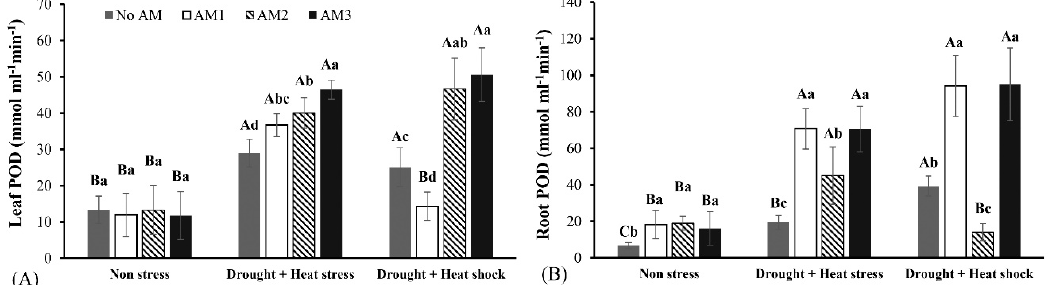
Figure 2. The activity of peroxidase (POD) in leaves ( A ) and roots ( B ) of non-inoculated plants (No AM) and plants inoculated by R. irregularis (AM1), F. mosseae (AM2), or F. coronatum (AM3) subjected to non-stress (NoS), drought + heat stress (D + H), and drought + heat shock (D + HS). Each bar represents the mean and standard deviation (n = 4). Di ff erent minuscules indicate significant di ff erences among treatments under the same conditions (no stress, drought + heat stress, or drought + heat shock) by Duncan’s post hoc test at p ≤ 0.05. Di ff erent capital letters indicate significant di ff erences of the same treatments (No AM, R. irregularis, F. mosseae , or F. coronatum ) under di ff erent conditions (no stress, drought + heat stress, and drought + heat shock) by Duncan’s post hoc test at p ≤ 0.05.